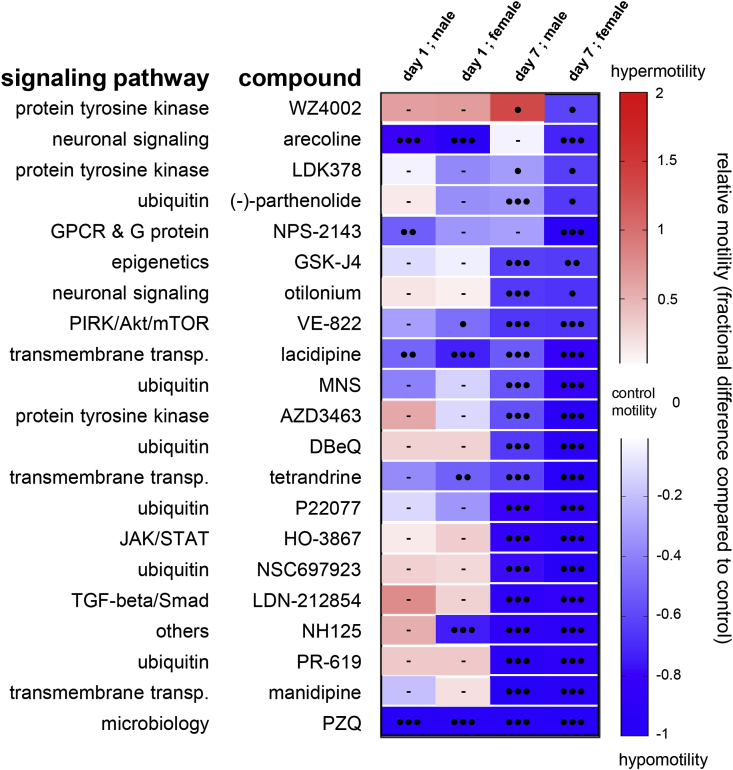
Motility assay on adult parasites treated with secondary screened compounds.Heat map of all secondary screened compounds. Motility rate was calculated relatively to control animals (DMSO-treated). Blue and red colors correspond to hypo- and hypermotility respectively. Black circles indicate p value < 0.0005 (3), <0.005 (2), <0.05 (1). Bars represent no significant change in motility rate compared to control. (For interpretation of the references to color in this figure legend, the reader is referred to the Web version of this article.)